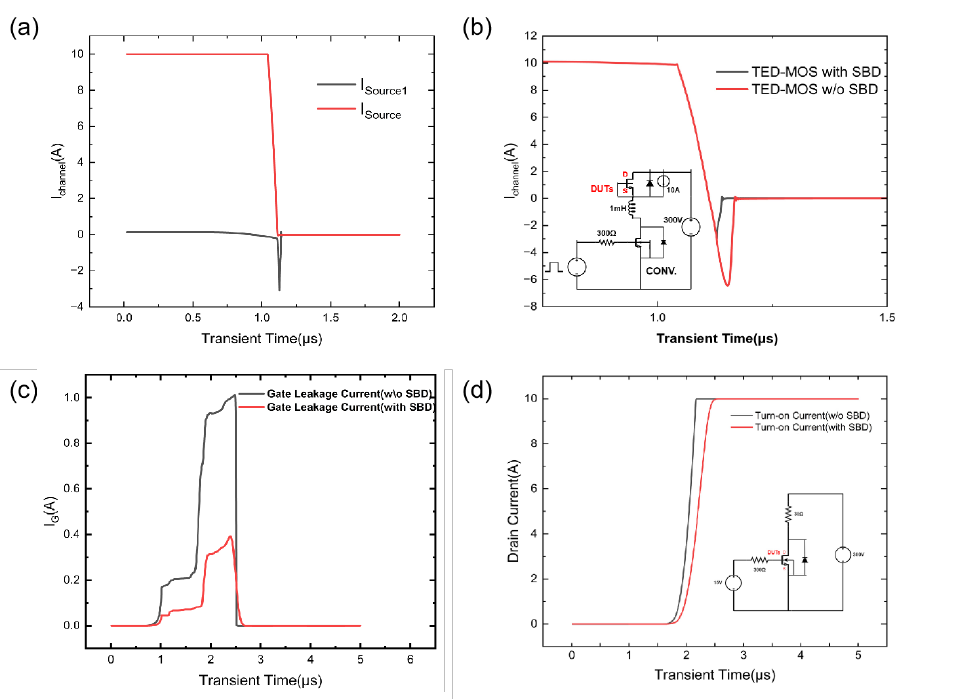
Figure 4. ( a ) Two reverse recovery currents of SiC TED MOS with SBD ( b ) Total reverse recovery current of SiC TED MOS with SBD; ( c ) Leakage current under DUTs test; ( d ) Turn-on characteristic of studied SiC TED